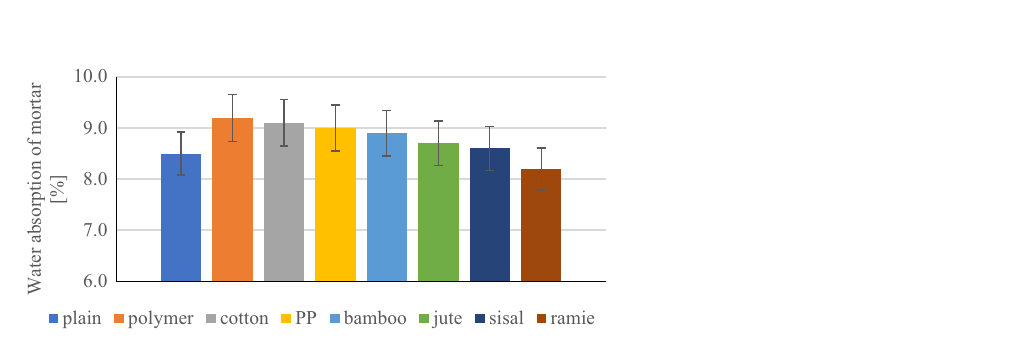
Figure 16. Testing the change in length of samples.